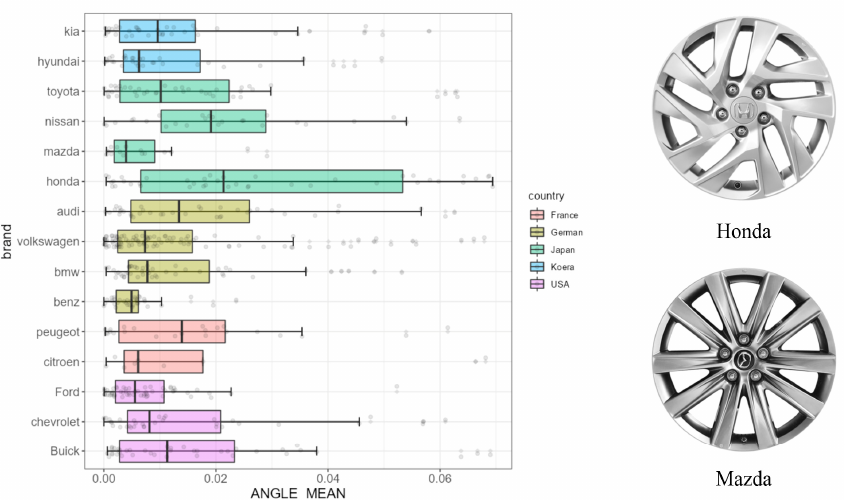
Figure 18. Spoke angle based on di ff erent brands. The x-axis is the average spoke angle on each wheel and the y-axis is the brand. The larger the value, the greater the de fl ection of the overall wheel shape. In the graph, Honda has more overall de fl ection, while Mazda has essentially no de fl ection.